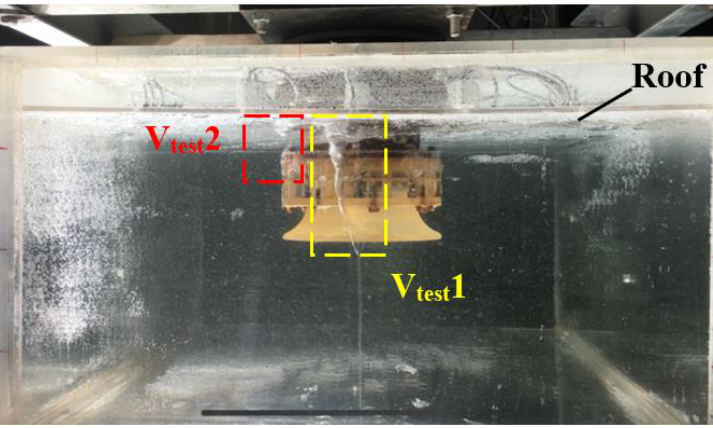
Figure 9. Experimental phenomena of RAV (side